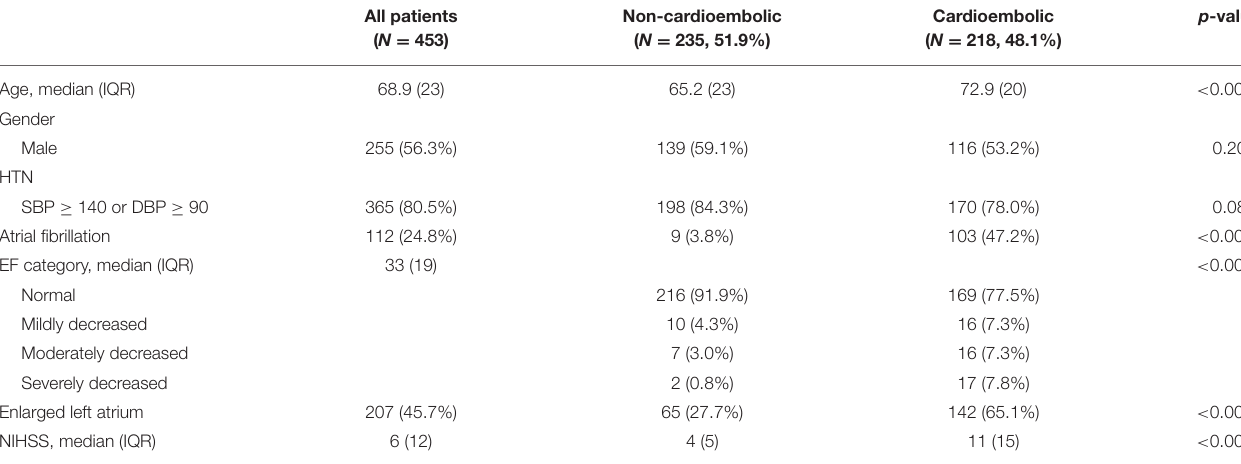
TABLE 1 | Demographic characteristics based on cardioembolic vs. non-cardioembolic stroke.